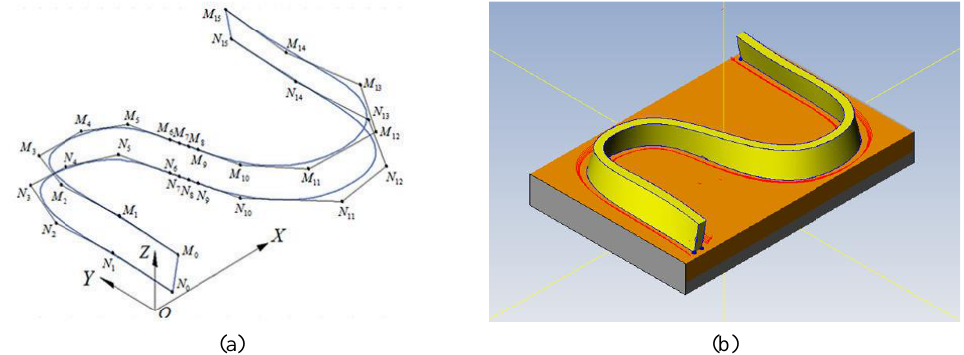
Figure 2. Geometrical definition and 3D CAD model of the proposed S-shaped workpiece: ( a ) Geometrical definition described in [14]; ( b ) 3D CAD model generated based on geometrical definition.